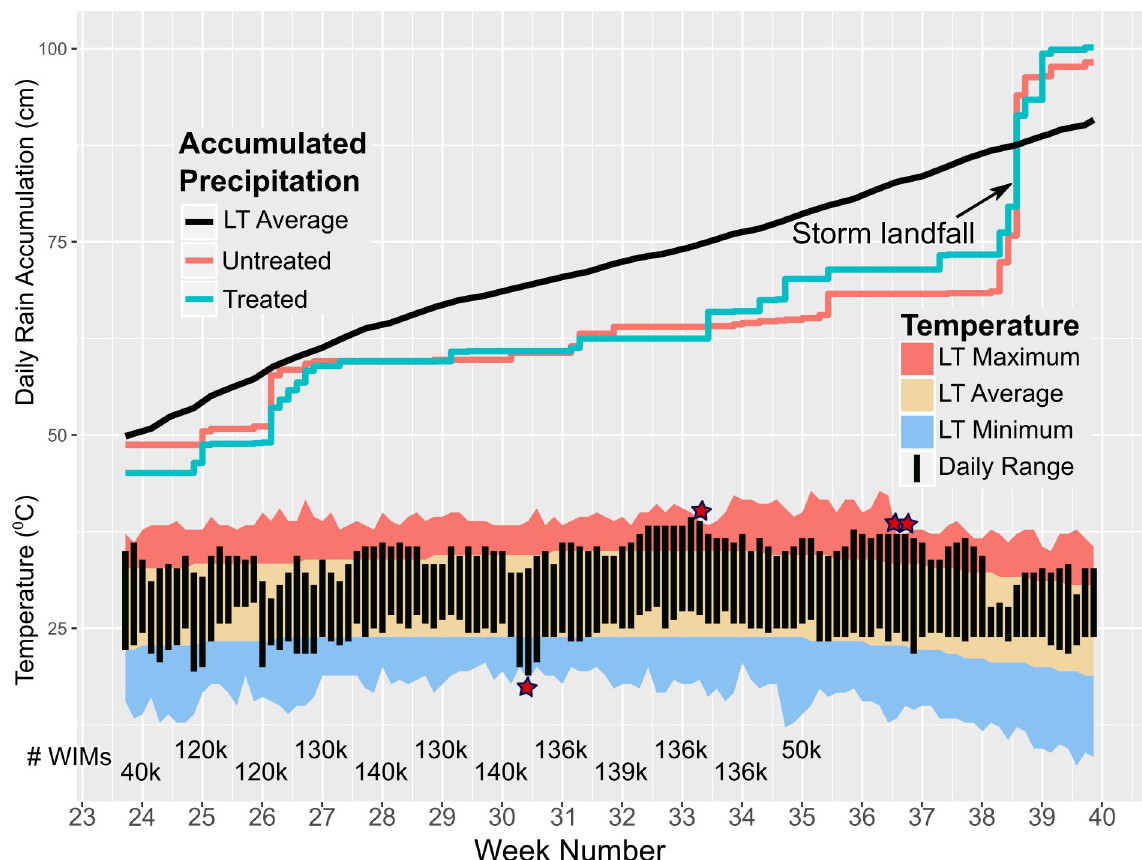
Fig 1. Average and observed daily cumulative rainfall, and temperature. Rainfall for each area was recorded at the nearest Harris County Flood Warning System weather station. The Long-term Rainfall (LT rainfall) is a 20-year average (1981–2001) recorded at Houston’s George Bush Intercontinental Airport (IAH). The LT Maximum, Average, and Minimum are 20-year averages (1981–2001) recorded at IAH. The observed daily temperature (bar; top of the bar observed maximum; bottom of the bar observed minimum) was recorded at IAH. Red stars show days when the temperature broke or tied the LT maximum or minimum. The number of released WIMs per week is presented at the bottom of the plot (k = x 1000). Climate and Weather data Source: National Weather Service and Harris County Flood Warning System. Raw data in S3